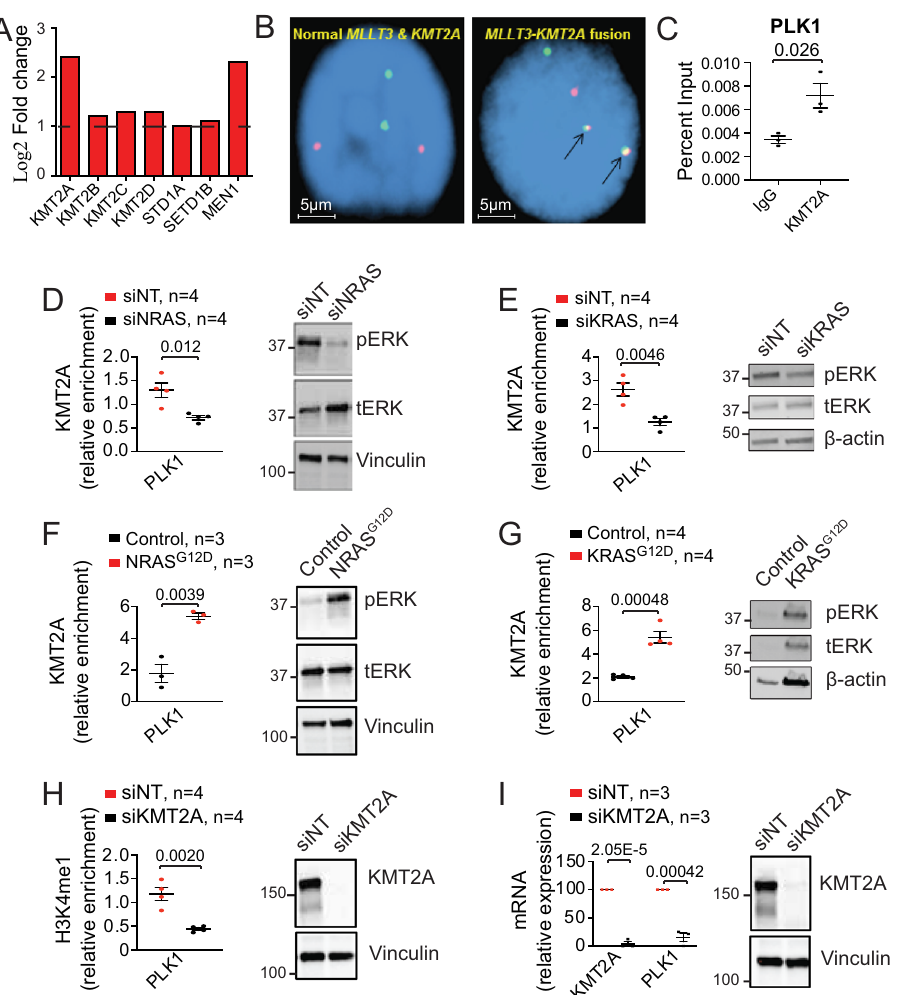
Fig. 6 Mutant RAS regulates PLK1 expression through the lysine methyltransferase KMT2A (MLL1). A RNA-seq expression levels of enzymes potentially involved in monomethylation in pCMML (vs dCMML and healthy volunteers). B Representative fl uorescence in situ hybridization (FISH) in two patients assessing for MLLT3-KMT2A fusions ( n = 500 biological replicates). Arrows (right) indicate presence of fusion. C ChIP-PCR in NRAS mutant CMML patient-derived MNCs assessing KMT2A occupancy at the promoter of PLK1 with immunoprecipitation of KMT2A relative to isotype control (IgG). D , E ChIP-PCR assessing KMT2A occupancy at the PLK1 promoter in NRAS mutant ( D ) and KRAS mutant ( E ) CMML MNC after transfection with siNT or siNRAS/siKRAS. Western blots are representative validation of RAS knockdown from three experiments. F , G ChIP-PCR assessing KMT2A occupancy at the PLK1 promoter in NRAS wild type ( F ), and KRAS wild type ( G ) CMML MNC, after transfection with control vector or NRAS G12D / KRAS G12D . Western blots are representative validation of RAS expression. H , I ChIP-PCR assessing H3K4me1 at the promoter of PLK1 ( H ) and qPCR assessing levels of KMT2A and PLK1 ( I ) in NRAS mutant CMML MNC after transfection with siNT or siKMT2A. Western blots are representative validation of KMT2A knockdown. Western blots in panels D – I are representative of three experiments. Data in panels C – I are presented as mean ± SEM and indicated p -values by two-tailed Student ’ s t test. The indicated n represents the number of biologic replicates. Source data are provided as a Source Data fi